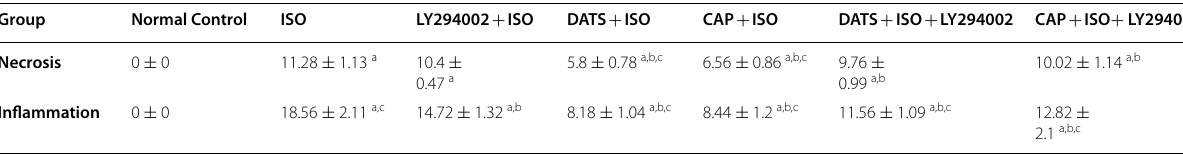
Table 3 Effect of treatment on cardiac histopathological scoring of necrosis and inflammation in the studied groups